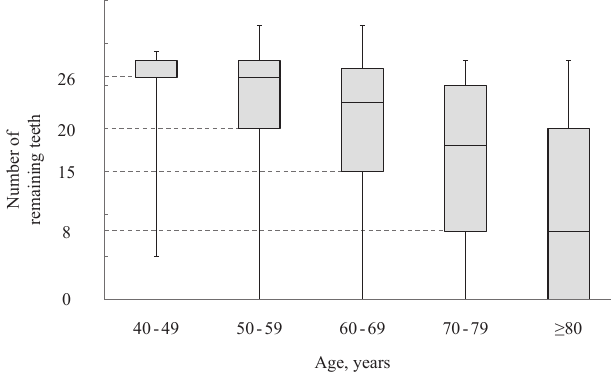
Figure 1. The distribution of the number of remaining teeth for each 10-year age category: NIPPON DATA2010. The lower and upper sides of the box indicate the fi rst and third quartiles, respectively. The line that divides the box into two parts shows the median. The lower and upper whiskers indicate the locations of the minimum and maximum,